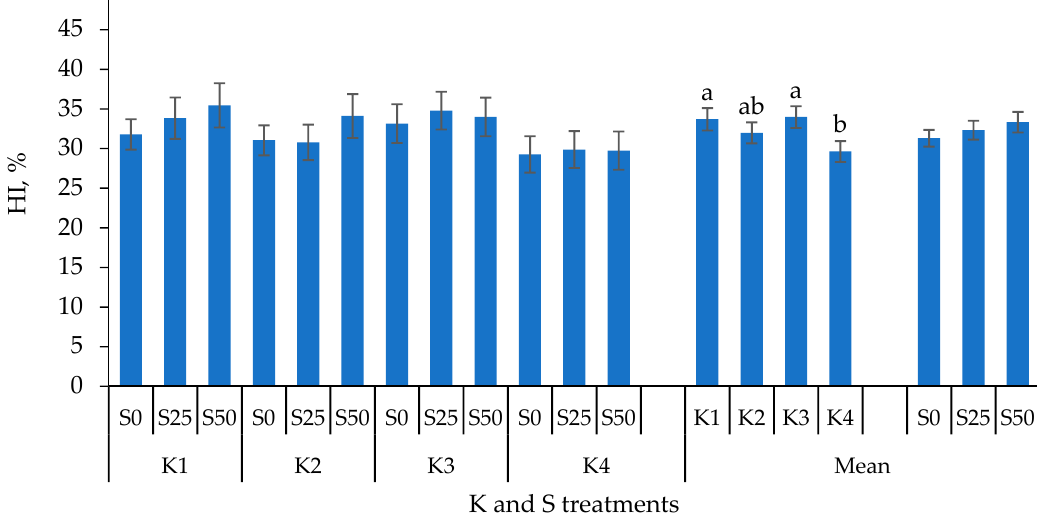
Figure 3. Effect of K treatments and S application on harvest index (HI) of faba bean. K1, K2, K3, and K4 refer to levels of soil K availability and fertilization; S0, S25, and S50 refer to sulfur application at rates of 0, 25, and 50 kg S ha − 1 , respectively. Means followed by the same letter are not statistically different ( p < 0.05). Hatched bars represent 2 × standard error (SE) ranges.